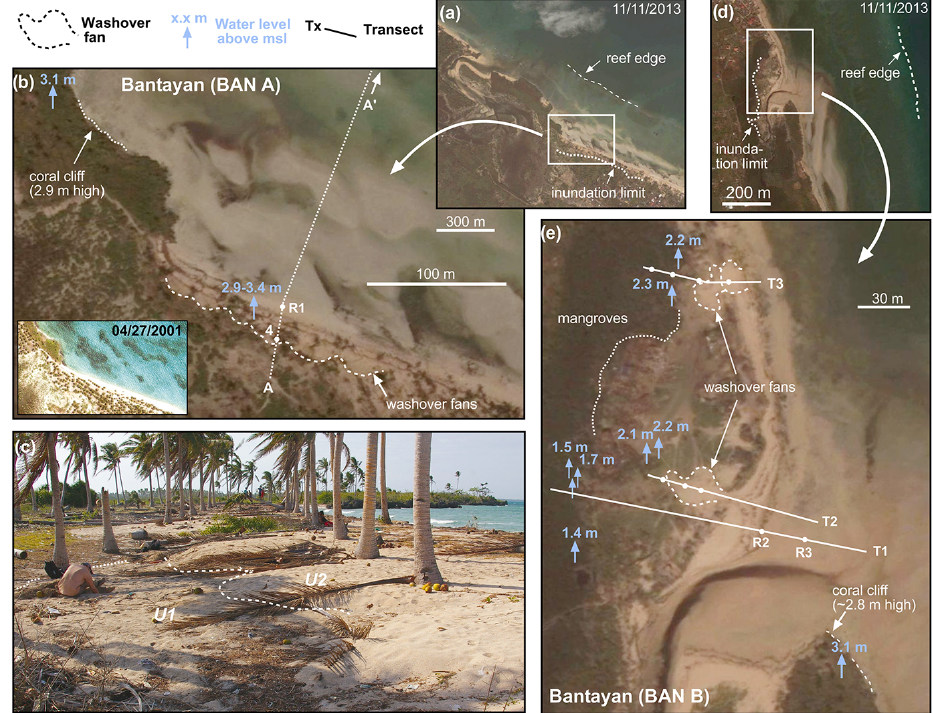
Figure 11. Bantayan study sites (BAN A and BAN B) with documented flood marks and geomorphological impact of Typhoon Haiyan. (a–b) At BAN A, Haiyan flooded the proximal part of the back-barrier plain and formed a series of small, overlapping washover fans directly behind the beach ridge (based on Google Earth/Digital Globe, 11 November 2013; inset in b 27 April 2001). (c) The washover fans reveal flat lobes at the base (U1) and steep lobes on top (U2). (d–e) At BAN B, flooding levels of more than 3m above msl generated several distinct washover fans (based on Google Earth/Digital Globe, 11 November